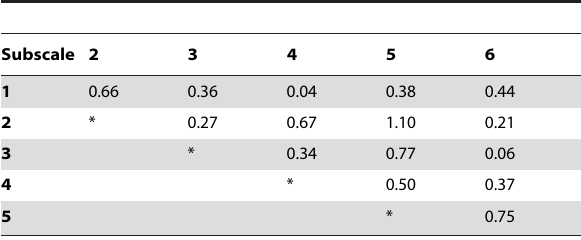
Table 5. Effect sizes (Cohen’s d) of differences between stigma subscales.